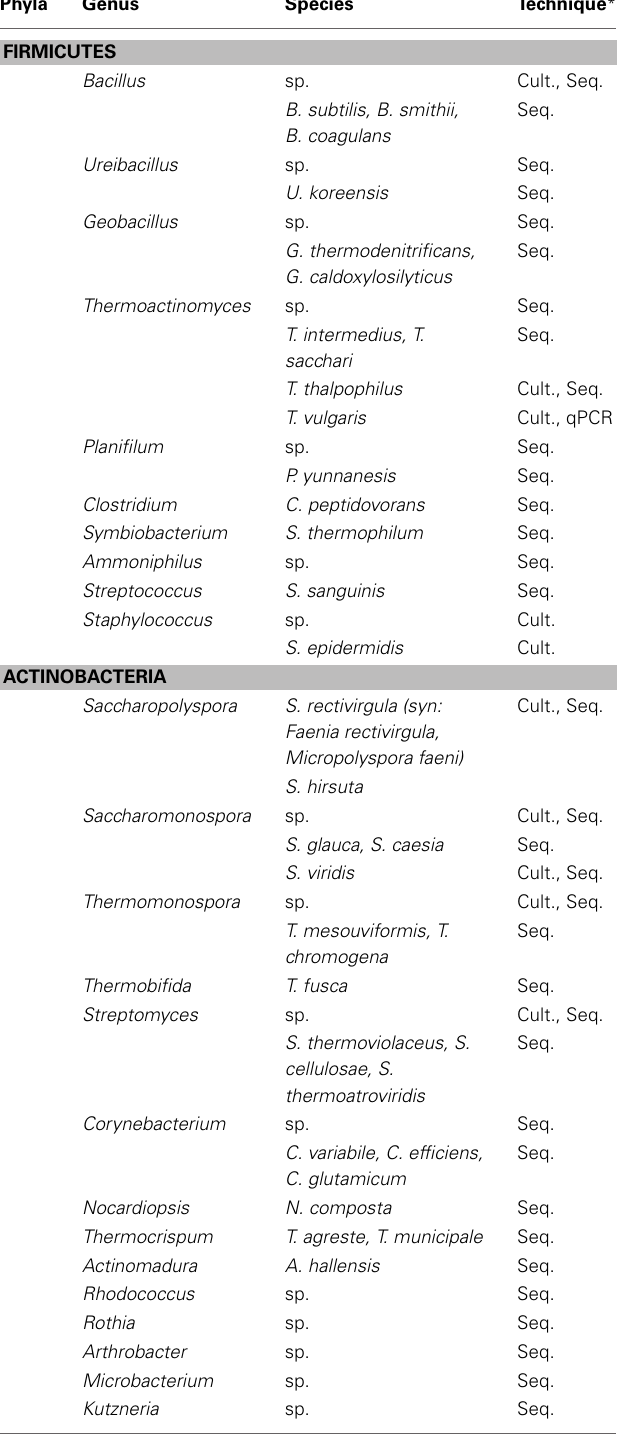
Table 1 | Dominant bacteria identified in aerosols from composting facilities using culture-dependent and culture independent techniques from Reinthaler et al. (1997), Le Goff et al. (2010), Bru-Adan et al. (2009), ADEME (2012), Pankhurst et al. (2012), and Betelli et al.